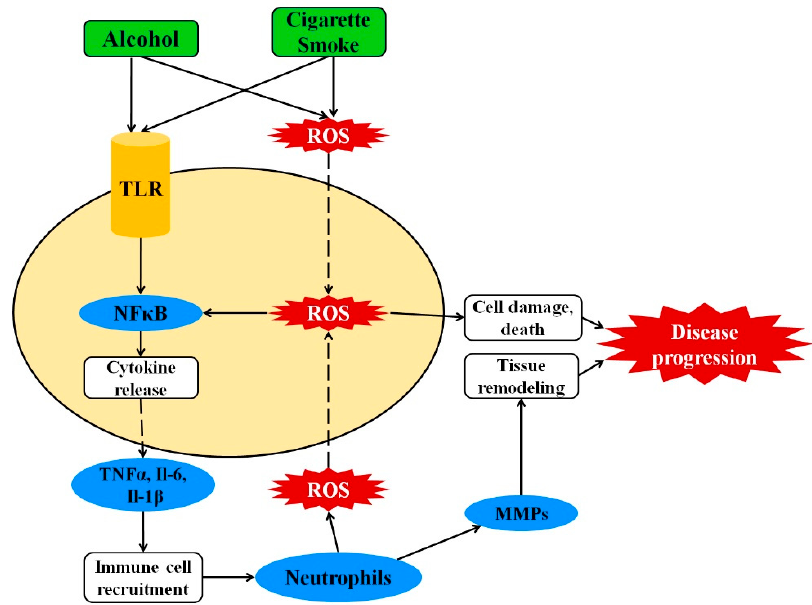
Figure 1. Cigarette smoking and alcohol drinking induce the oxidative and inflammatory response. Exposure to cigarette or alcohol leads to oxidative stress and stimulation of NF κ B. NF κ B promotes secretion of proinflammatory cytokines TNF α , IL-6, and IL-1 β , which then strengthen immune cell recruitment. Recruited neutrophils produce additional ROS and release metalloproteases, which induce cell damage and matrix degradation, respectively. The net result of constitutive activation of inflammatory pathways is tissue destruction and disease progression. Abbreviations: NF κ B, nuclear factor kappa-light-chain-enhancer of activated B cells; TLR, toll-like receptor; TNF α , tumor necrosis factor α ; IL, interleukin; ROS, reactive oxygen species.